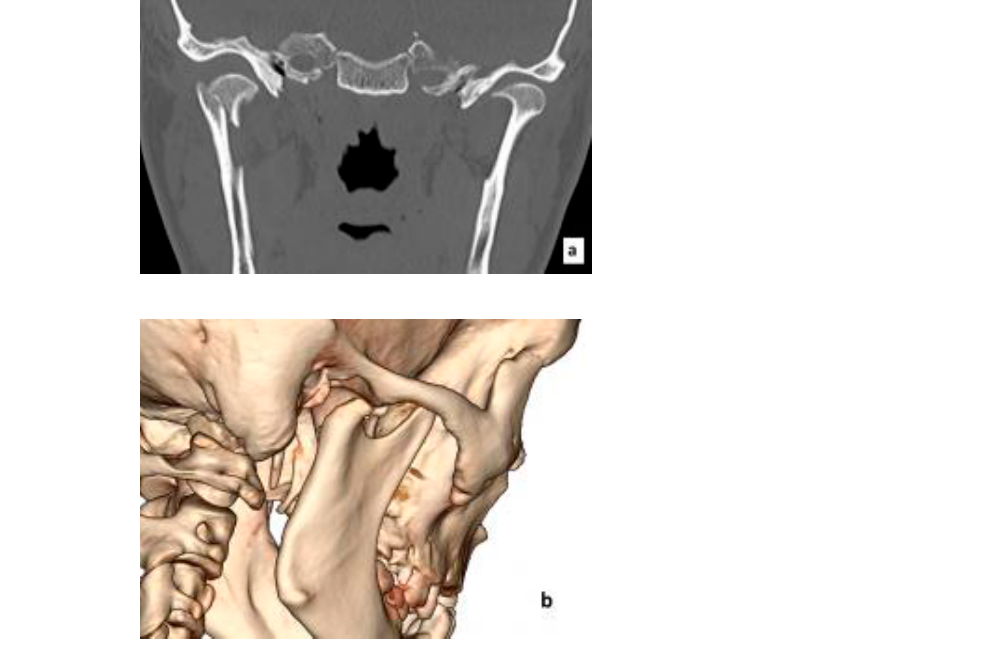
Figure 1. Fracture of the right mandibular head. Computed tomography: frontal scan ( a ) and 3D reconstruction ( b ).